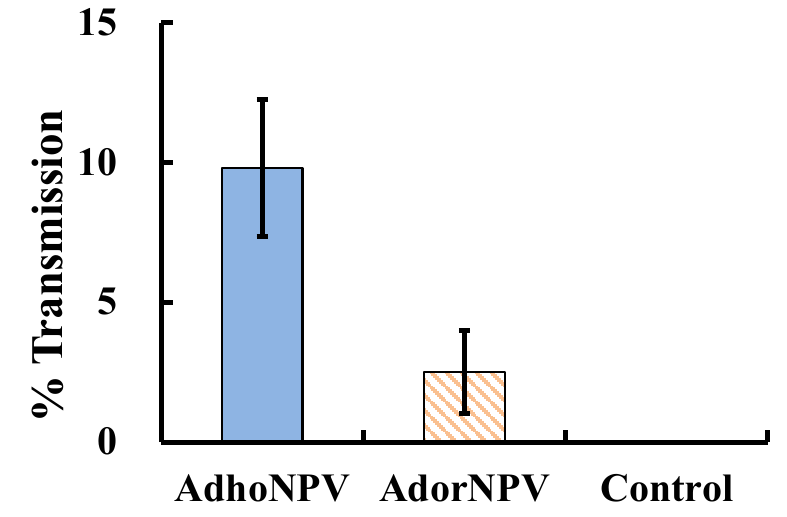
Figure 5. Transmission rate of AdhoNPV and AdorNPV to A. honmai larvae in the next generation. Percentage mortality of A. honmai larvae released at 34 days after spraying AdhoNPV and AdorNPV on tea leaves. A solution of spreading agent without virus was sprayed as the control. Bars indicate standard